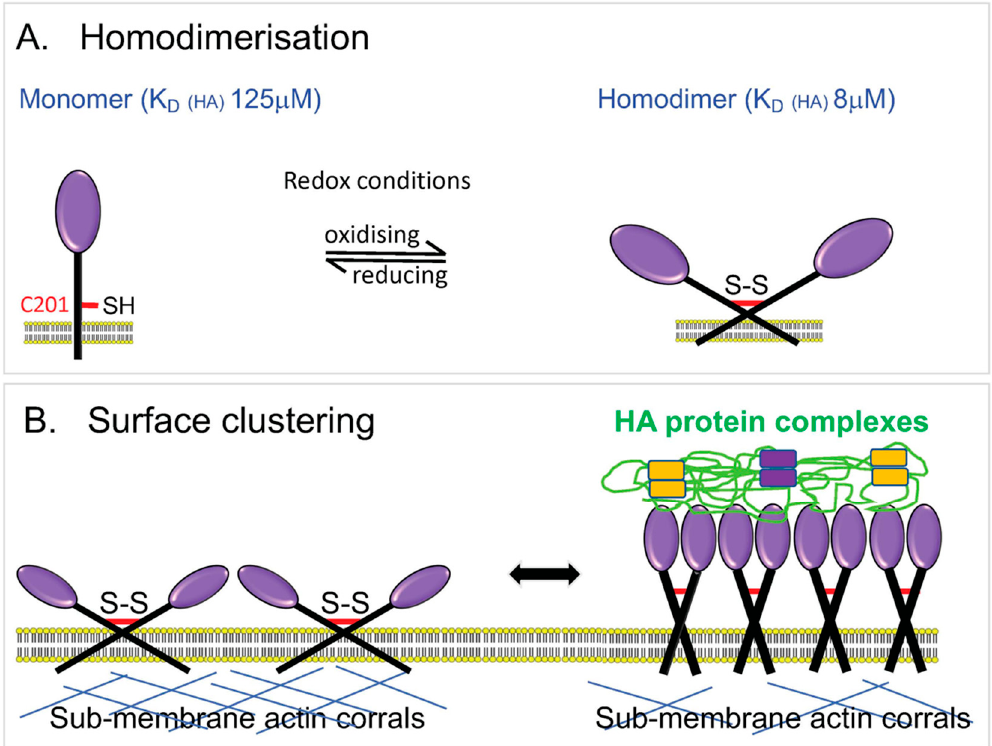
Figure 5. Characteristics of LYVE-1 that regulate its interactions with HA in lymphatic endothelium. ( A ) Endogenous LYVE-1 forms homodimers on the endothelial surface via an unpaired cysteine residue C201 in a process that is critical for HA-binding in vivo and which increases binding affinity some 15-fold as assessed by Biacore analysis [147]. The ratio of homodimer to monomer is subject to regulation by the local redox environment. ( B ) Engagement with HA also requires clustering of LYVE-1 on the endothelial surface, induced by interaction with cross-linked macromolecular HA • protein complexes that have heightened binding avidity (see also Figure 1), and local disassembly of the sub-membrane actin meshwork that normally constrains LYVE-1 lateral mobility in the plasma membrane [49,150]. The figure is modified from Jackson (2019) [23] with permission from the publisher (Elsevier).